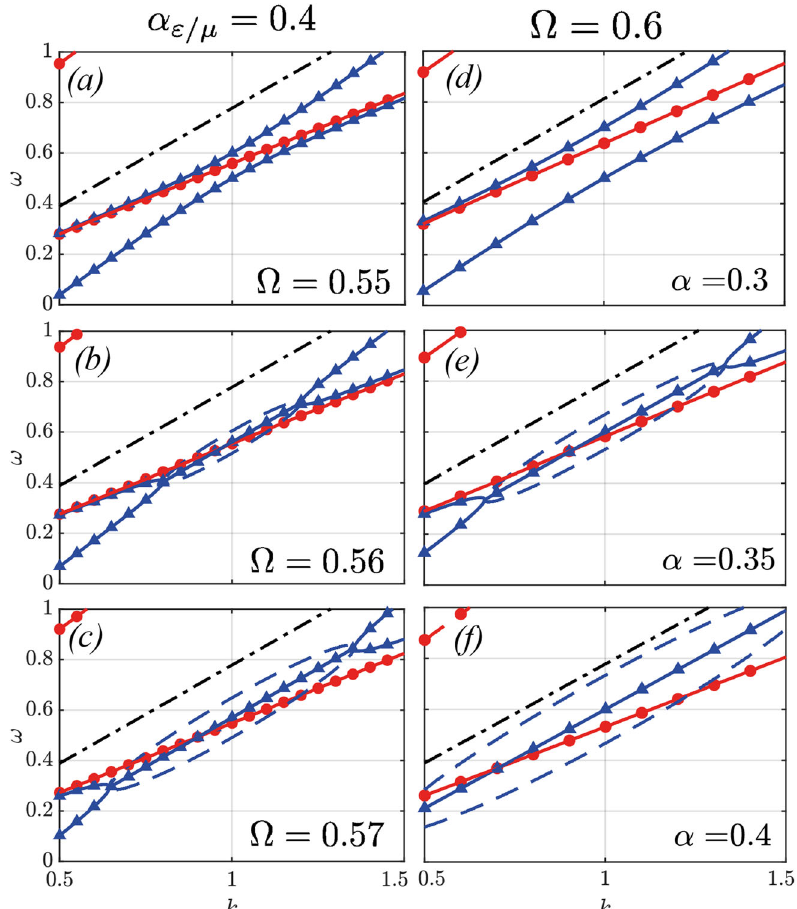
Fig. 6 Band-gap opening for ϕ = 0. In the left column ( a - c ) we vary Ω from 0.55 ( a ) to 0.57 ( c ) at a fi xed α = 0.4 and in the right column we vary α from 0.3 ( d ) to 0.4 ( f ) ad a fi xed Ω = 0.6. Notice how both parameters induce the attraction between the two bands that gives rise to the transition into the PT- broken phase.